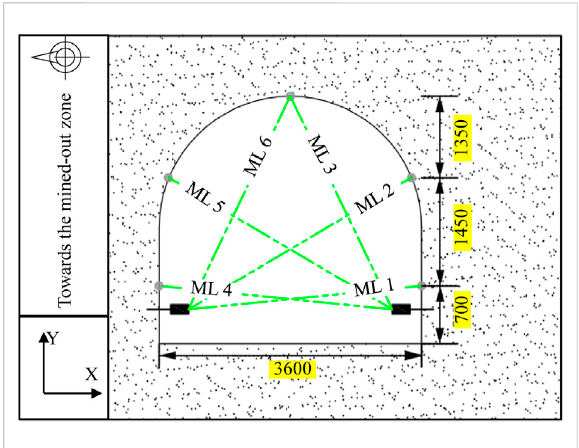
FIGURE 2 Measurement line layout of the laser convergence meter monitoring stations (ML means measurement